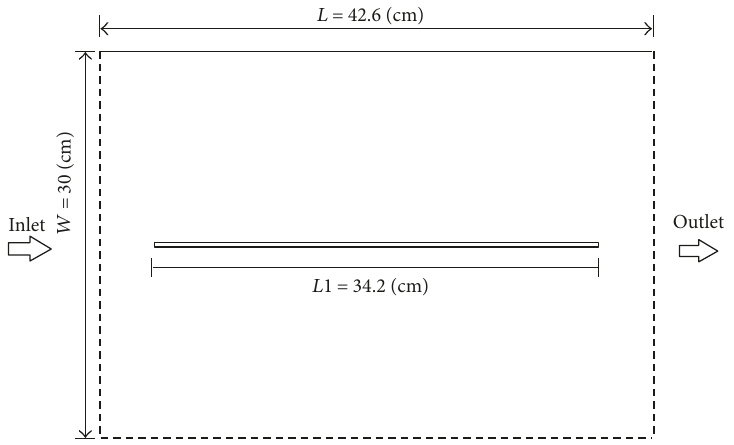
Figure 2: Schematic diagram of uncon fi ned fl ow on module.